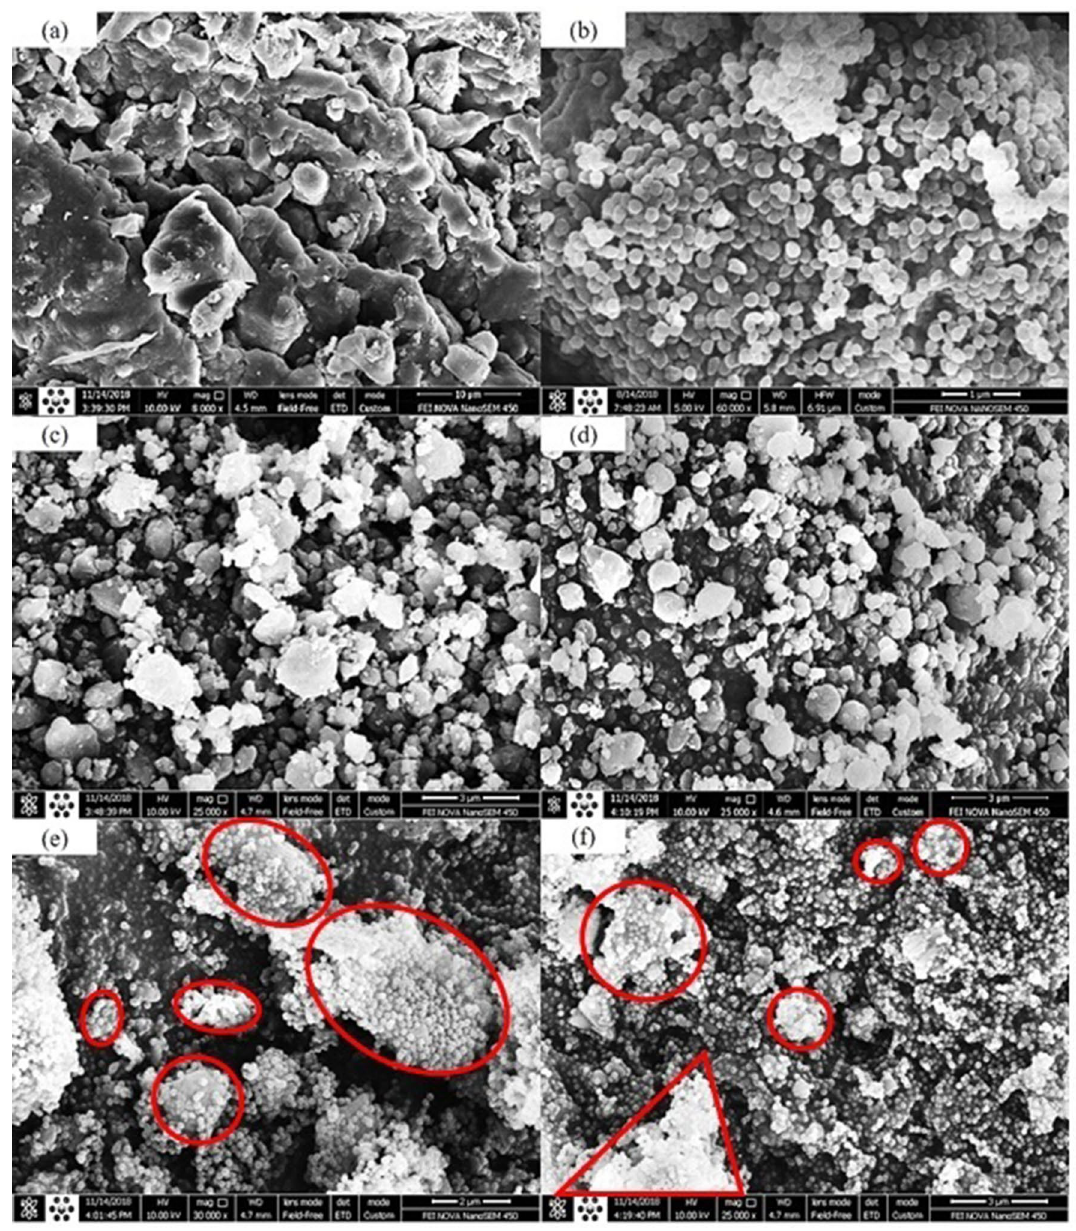
Fig. 2 SEM images of a MNB (as received MgH